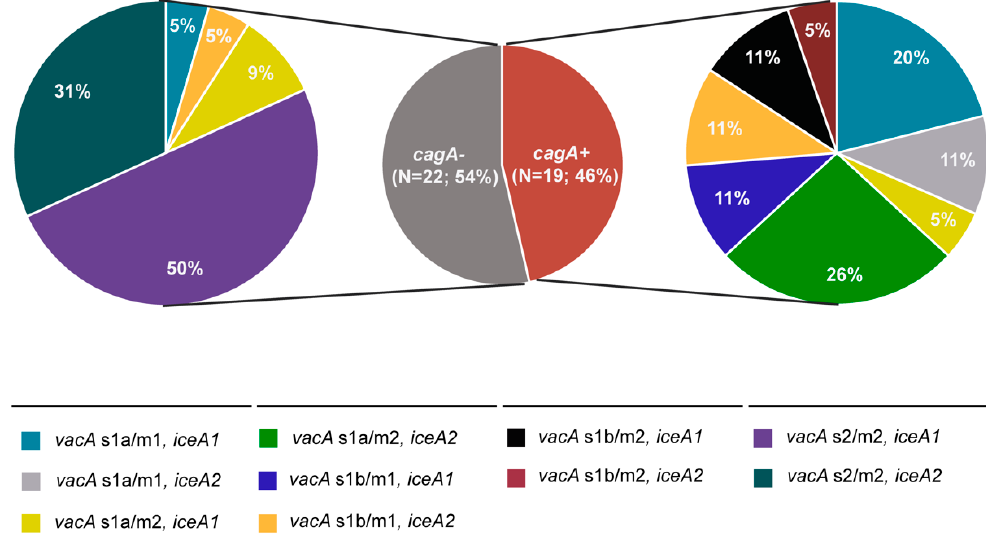
Figure 2. Determination of the presence of cagA , vacA and iceA in 41 H. pylori strains isolated from patients with non-atrophic gastritis.